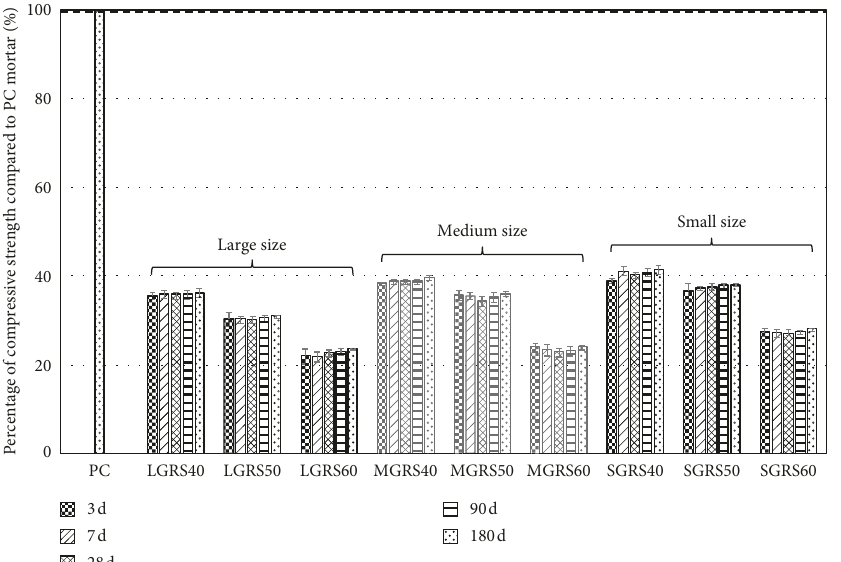
Figure 5: Percentage of compressive strength of mortars containing GRS with different particle